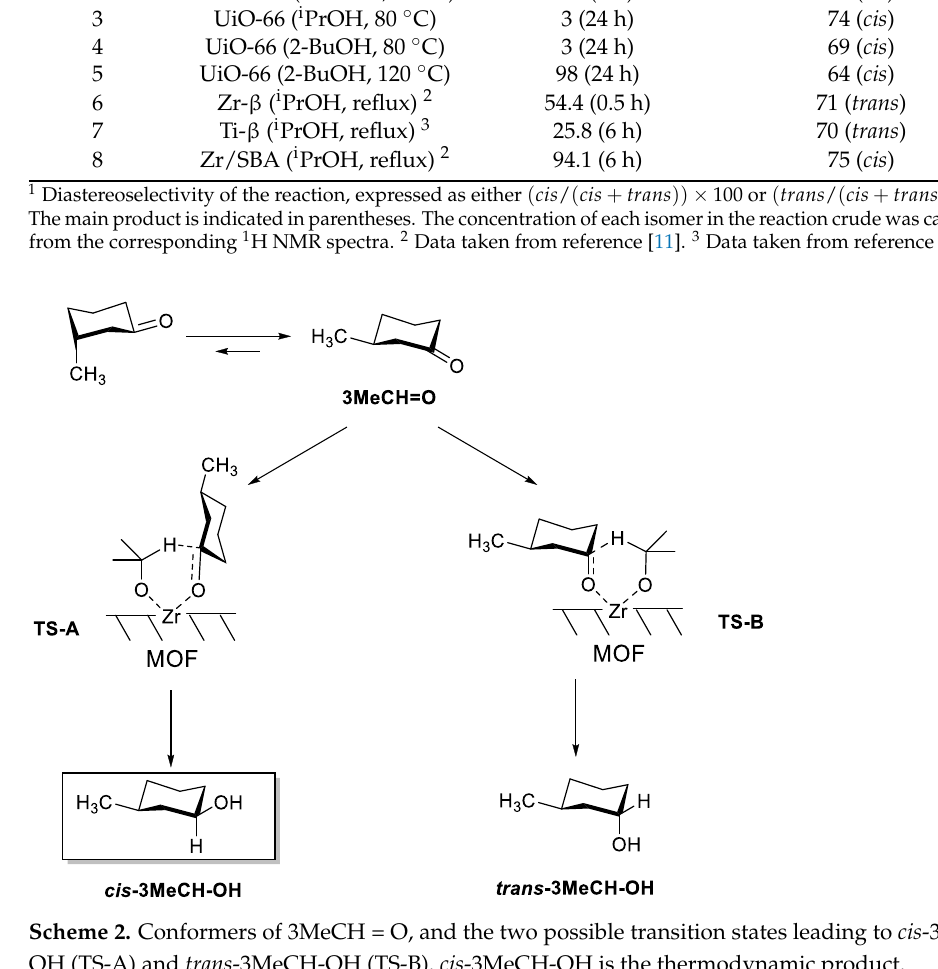
Table 1. MPV reaction of 3MeCH = O over various heterogeneous catalysts. 109